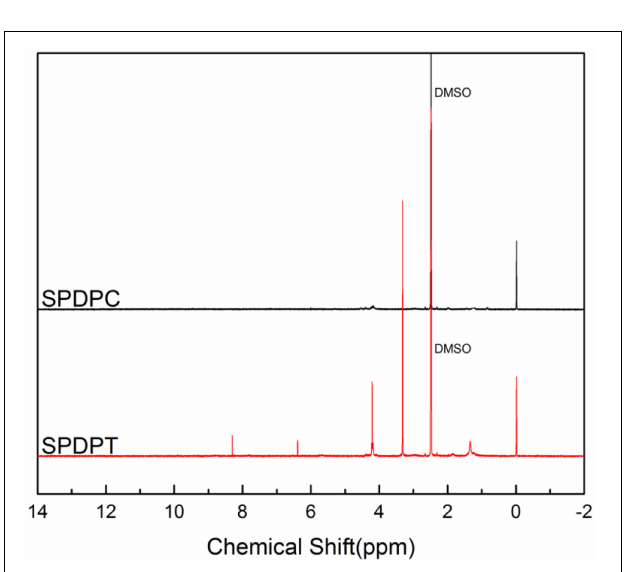
TABLE 2 | Elemental analysis of SPDPT.